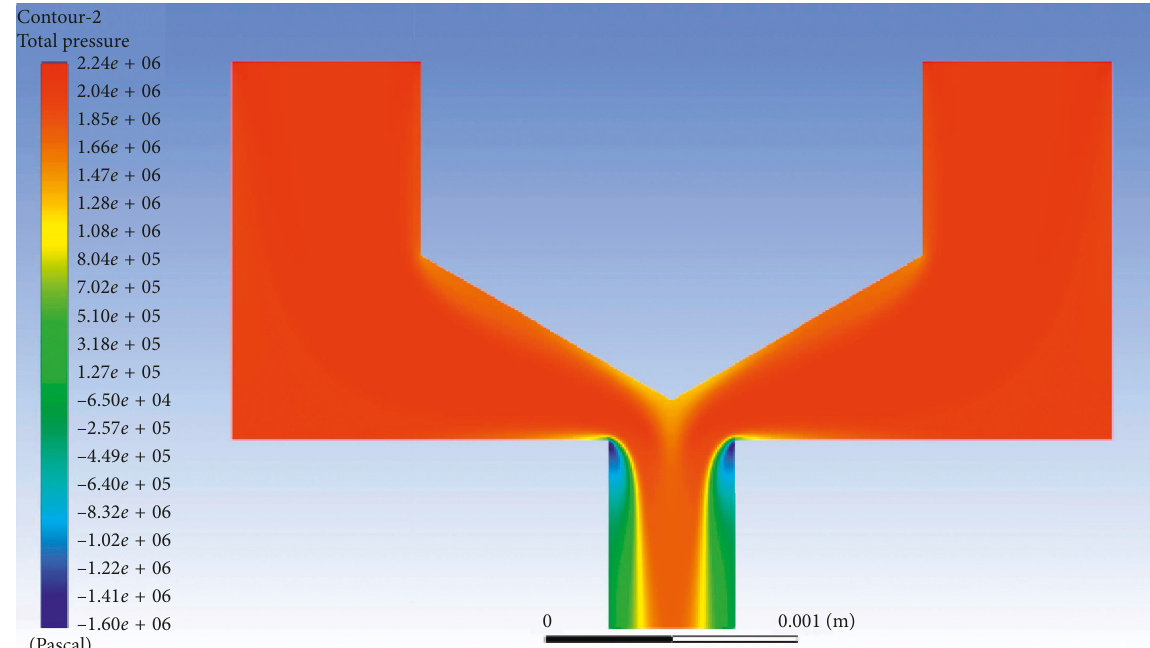
Figure 30: Pressure nephogram of 120 ° flow